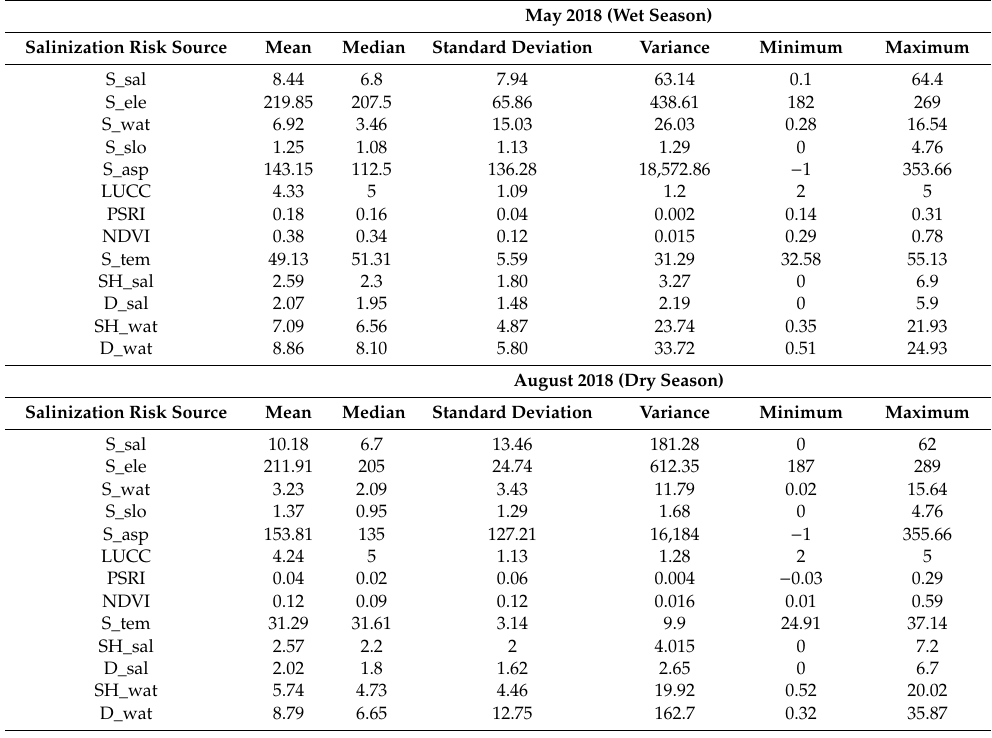
Table 3. Statistical characteristic values of risk assessment factors of salinization in dry and wet